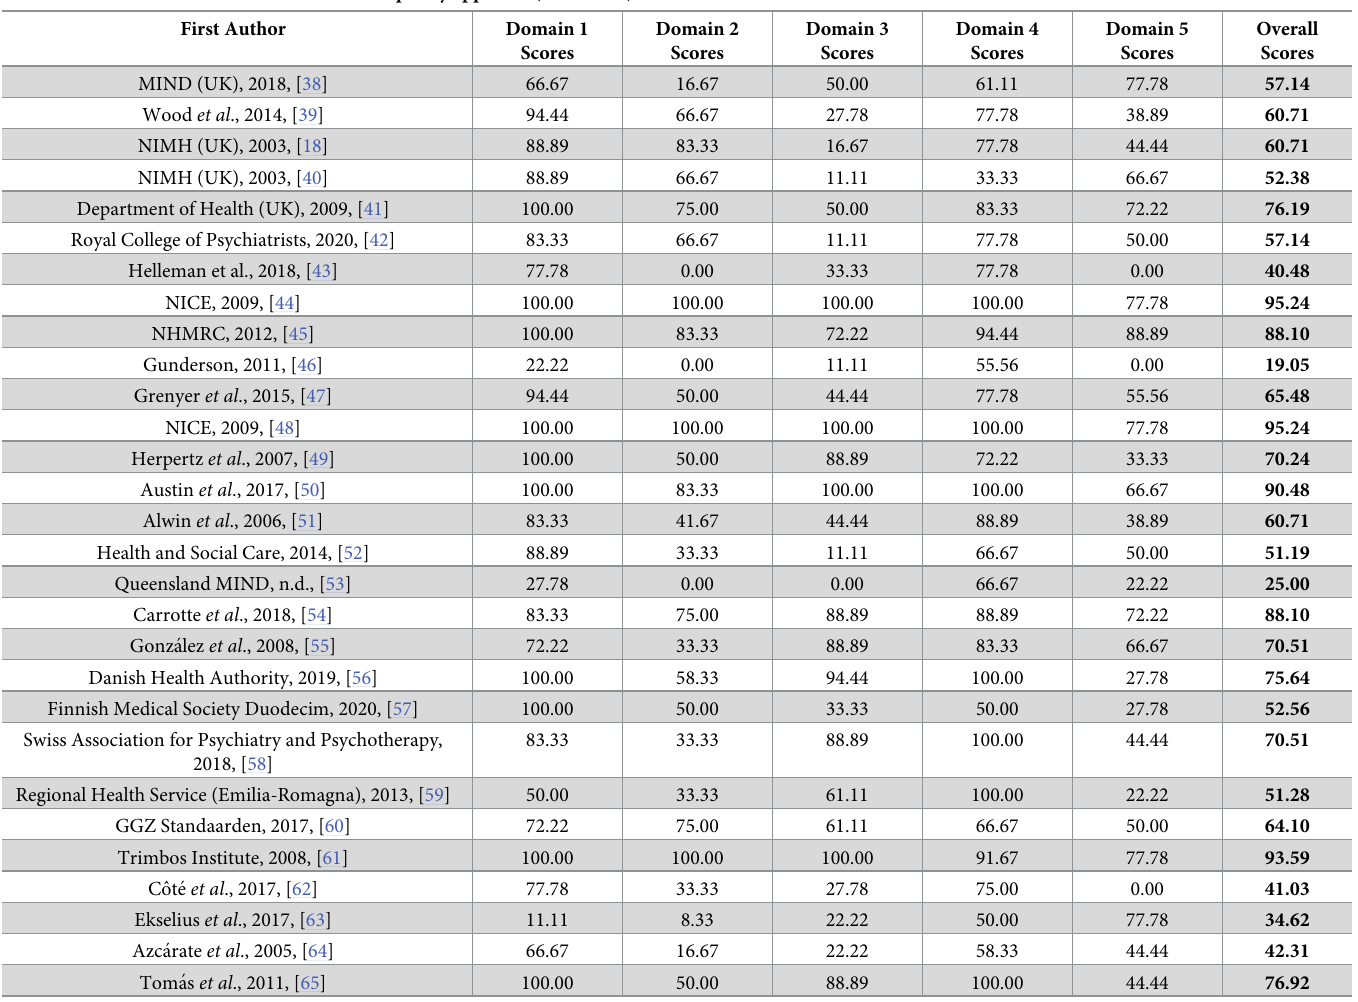
Table 2. Individual domain and total scores of quality appraisal